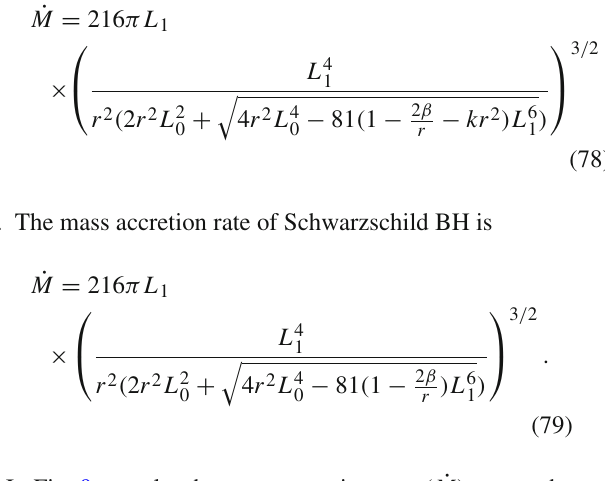
Fig. 8 In this figure, left panel (conformal gravity BH) displays the behavior of Eq. (71) with conformal parameters γ = 0 . 1, k = − 1, β = 1. Right panel (Schwarzschild–de Sitter BH) displays the behav- ior of Eq. (72) for Schwarzschild–de Sitter BH parameters γ = 0,